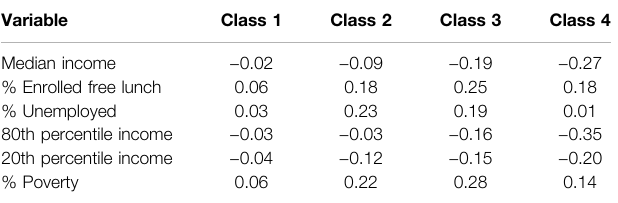
TABLE 16 | Correlation coef fi cients between the number of deaths per 1,000 residents and income and poverty variables within each latent